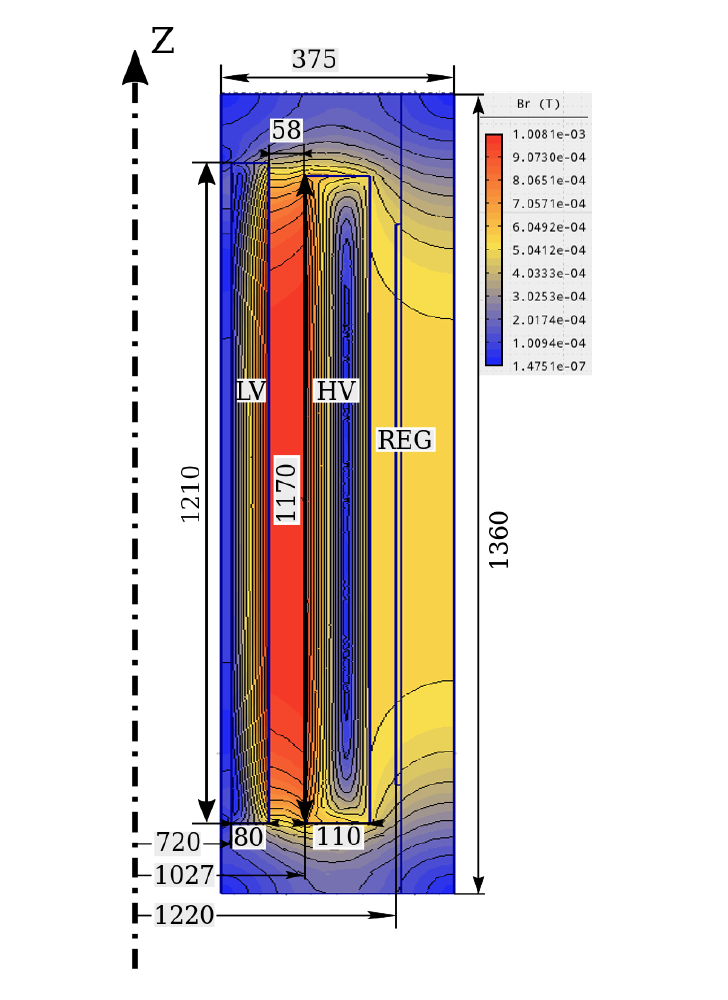
Figure 6. Results of the optimization process, namely optimal key-design parameters and magnetic flux distribution in window of optimized, 31.5 MVA, 132 kV/33 kV power transformer. The FEM calculation made by Agros2D [34]. Symbol LV means the low voltage winding, symbol HV represent the modeled high voltage